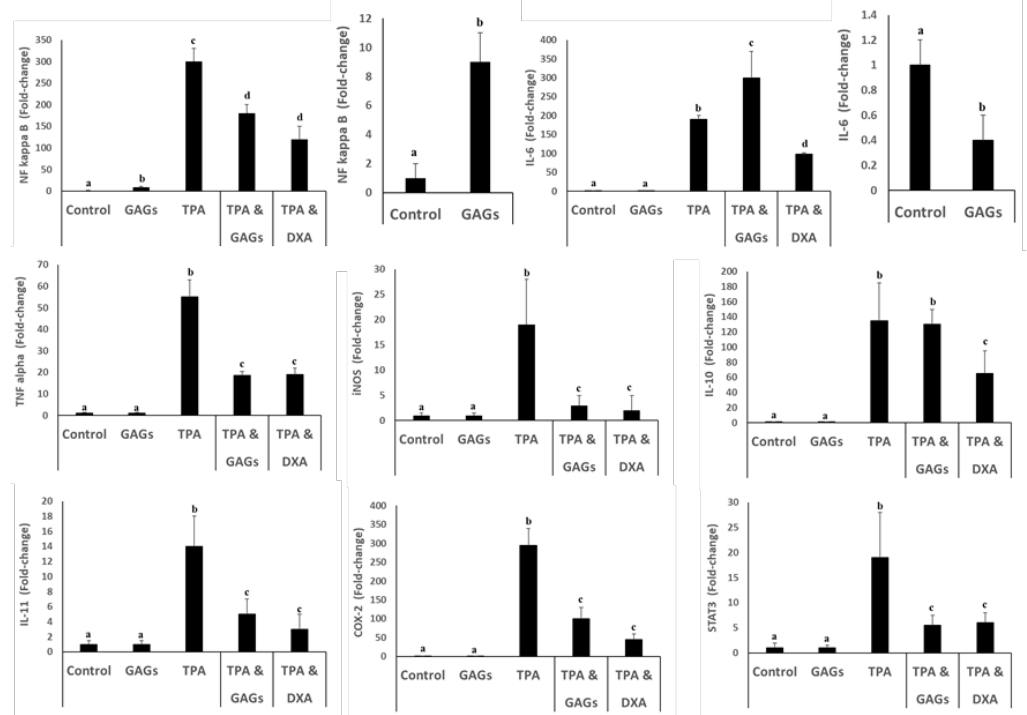
Figure 4. GAGs from sea cucumber ( I. badionotus ) target principal inflammation-related genes. Mouse ears were exposed to vehicle alone (left ear), GAGs, inflammatory agent TPA followed by GAGs, or TPA followed by dexamethasone (DXA) as an anti-inflammatory control (right ear). Genes NF kappa B (NF-kB), IL-6, TNF alpha (TNF α ), iNOS, IL-10, IL-11, COX-2 and STAT3 were evaluated by qRT-PCR. Values (fold change) are the mean ± SD. Values with distinct superscripts di ff er significantly from each other ( p < 0.05).